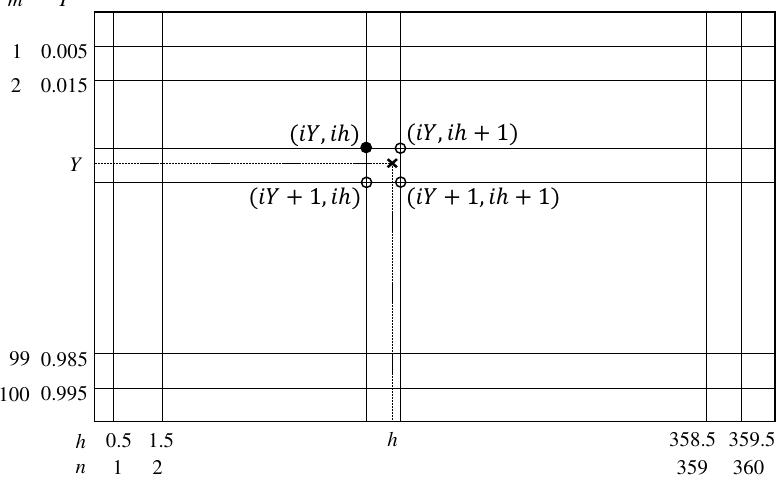
Figure 4. Assignment of maximum chroma value using lookup